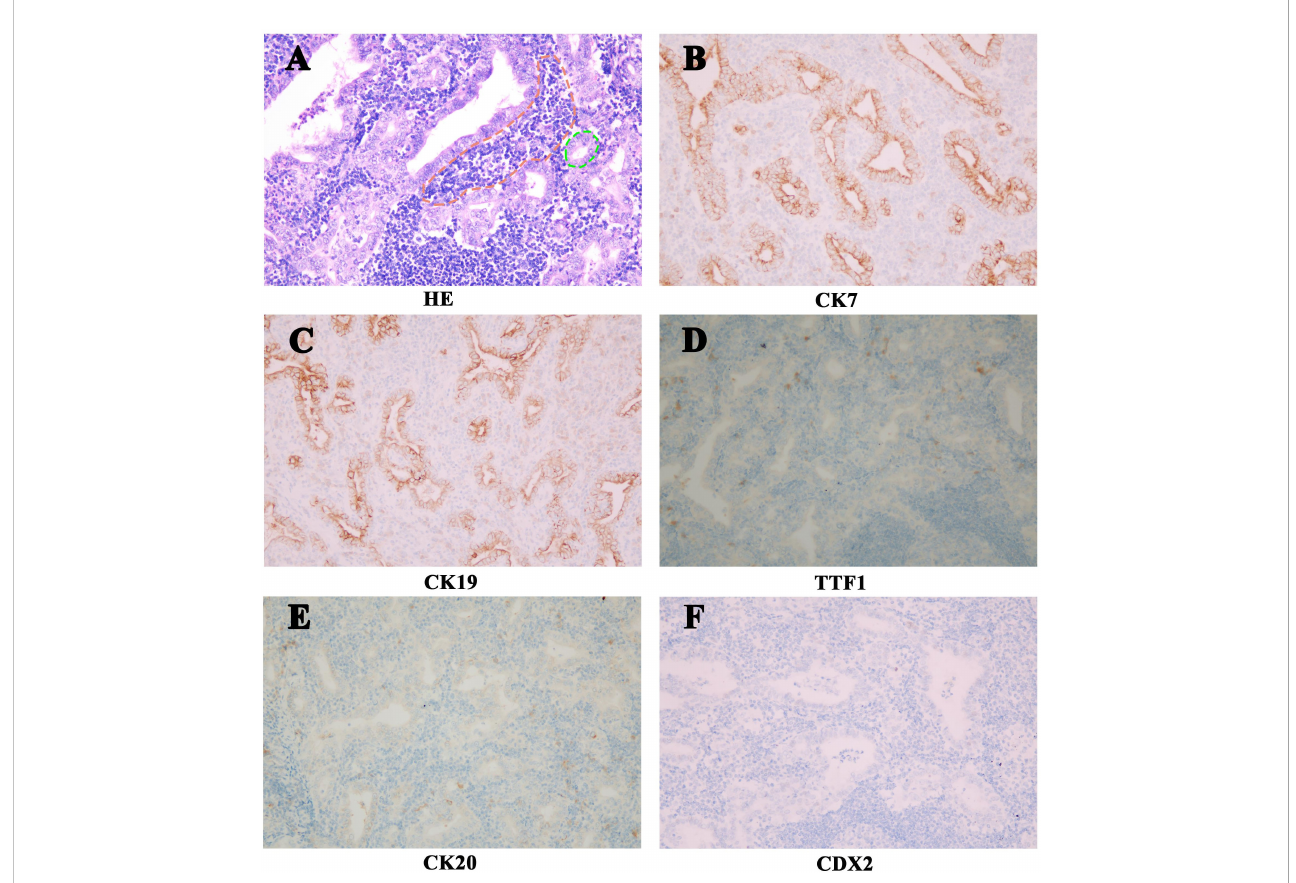
FIGURE 3 The Histologic features of the LELCC. (A) Hematoxylin - eosin staining (HE, 200×) shows poorly differentiated bile duct cells (Green) with lymphocytic in fi ltrates (Red). Immunohistochemically (200×), the tumor cells showed (B) CK7 and (C) CK19 expression, while no expression of (D) TTF1, (E) CK20 or (F) CDX2